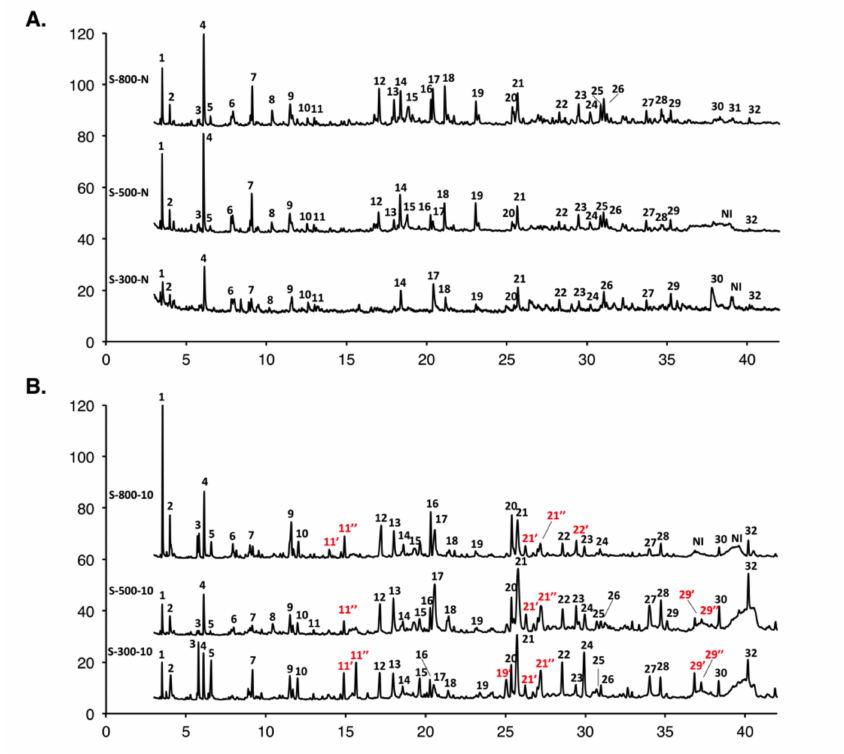
Figure 5. Total ion chromatograms for the liquid fractions of the samples of the 1st category ( A ) and the 2nd category ( B